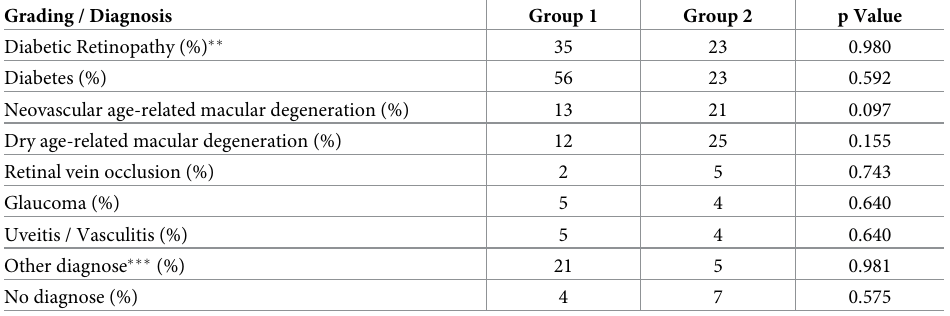
Table 1. Distribution of graded diabetic retinopathy and assigned (ocular) diagnoses � . Grading / Diagnosis Group 1 Group 2 p Value Diabetic Retinopathy (%) �� 35 23 0.980 Diabetes (%) 56 23 0.592 Neovascular age-related macular degeneration (%) 13 21 0.097 Dry age-related macular degeneration (%) 12 25 0.155 Retinal vein occlusion (%) 2 5 0.743 Glaucoma (%) 5 4 0.640 Uveitis / Vasculitis (%) 5 4 0.640 Other diagnose ��� (%) 21 5 0.981 No diagnose (%) 4 7